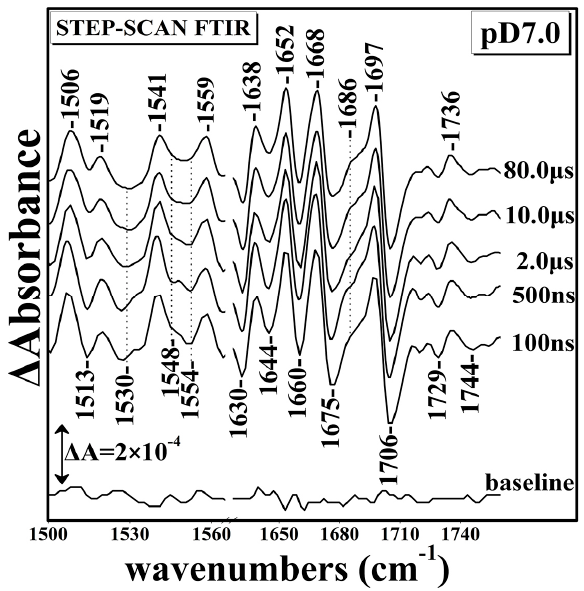
Figure 4. Time Resolved Step-Scan Fourier Transform Infrared (TRS 2 -FTIR) difference spectra of 1500–1760 cm − 1 region ( t d = 100–80,000 ns, 4 cm − 1 spectral resolution) of fully-reduced ba 3 -CO subsequent to CO photolysis by a 7 ns 532 nm laser pulse at pD 7.0.